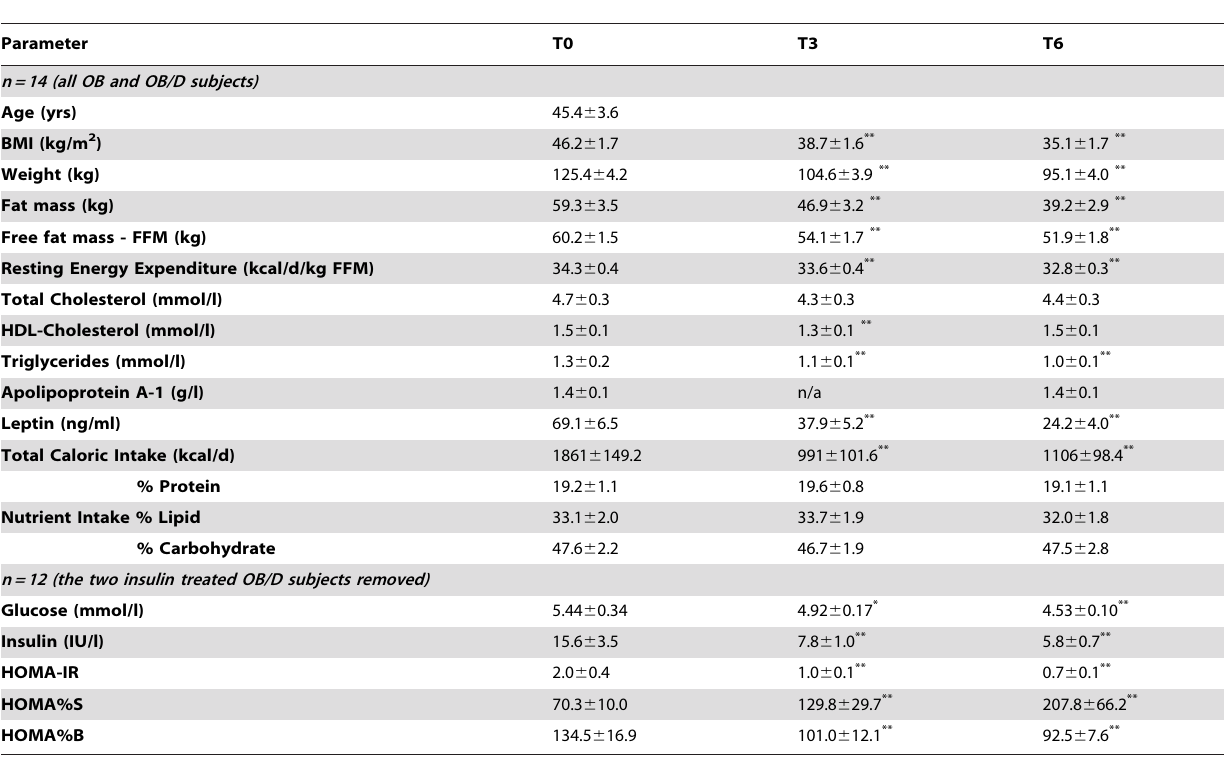
Table 1. Clinical data in subjects at all 3 time points (T0, T3, and T6)